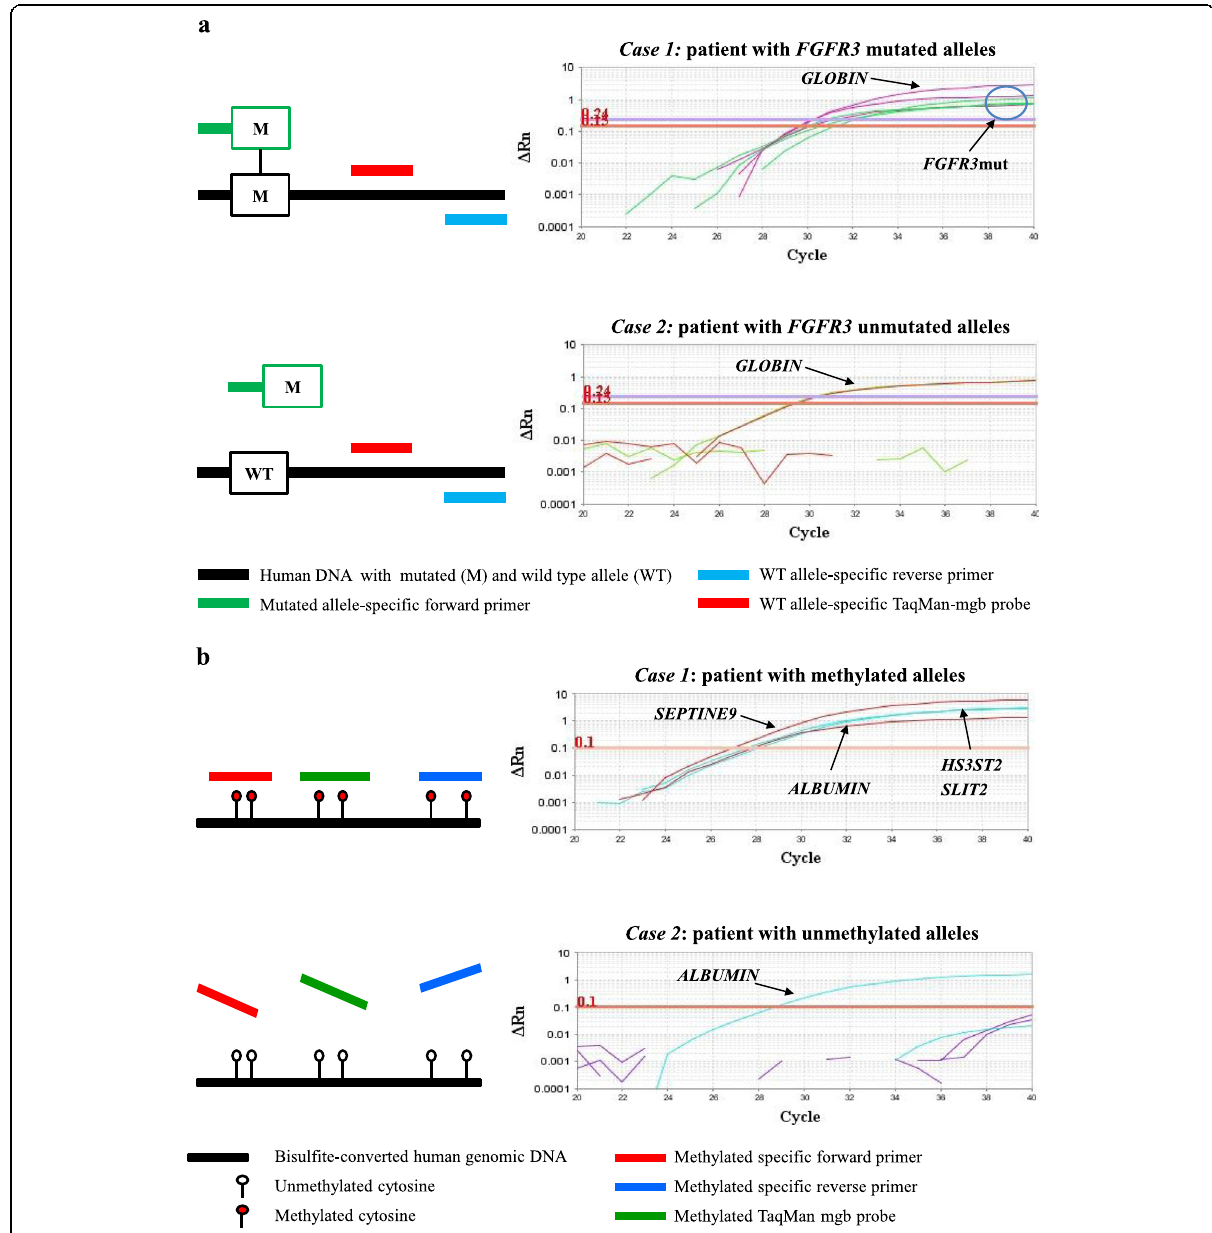
Fig. 1 a – b Design of Mutation and Methylation PCR assays. The diagram 2a illustrates the Mutation assay with the position of the primers